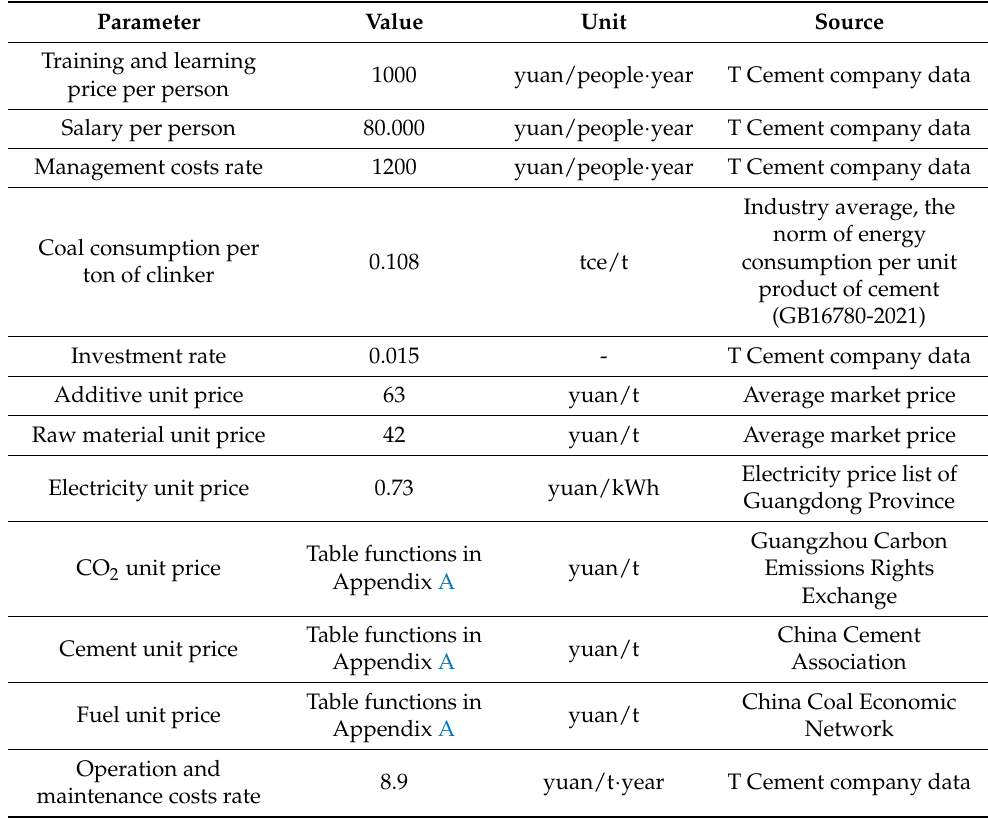
Table A2. The parameters of economic efficiency subsystem.